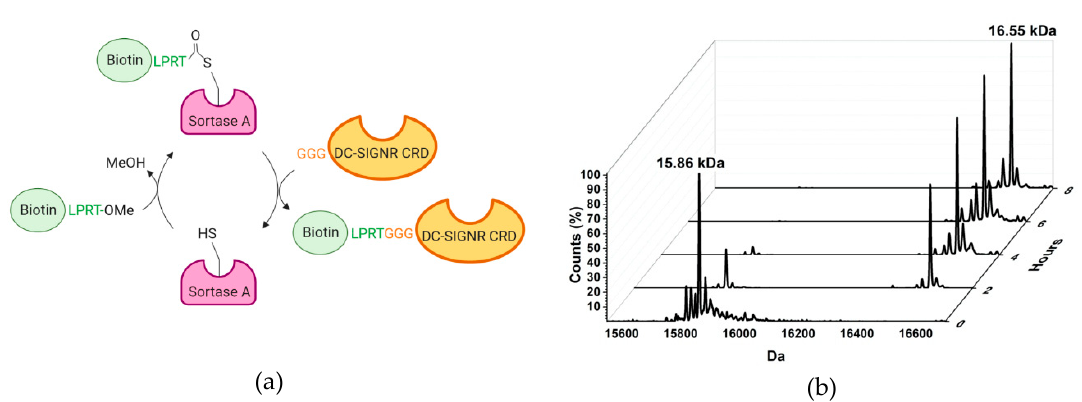
Figure 2. N-terminal biotin sortagging of DC-SIGNR-CRD. ( a ) Schematic representation of the reaction. ( b ) DC-SIGNR-CRD labeling followed by ESI-MS. The peak at 15,862 kDa corresponds to un-labeled CRD and the peak at 16,556 kDa corresponds to biotinylated CRD (15,862 + 0.694 kDa). After 6 h of reaction, the biotinylation reaction is completed.